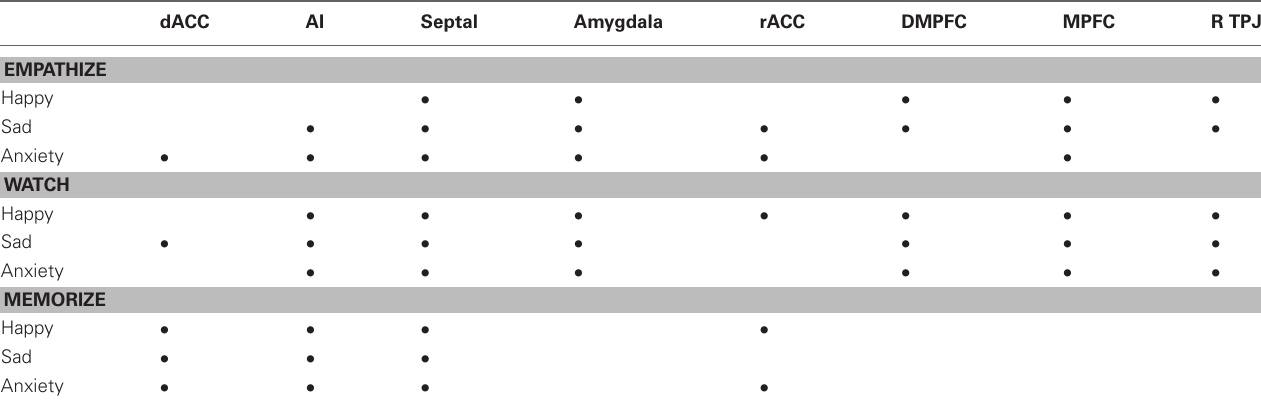
Table 1 | Patterns of neural activity for each instruction type (compared to viewing neutral photos) within anatomically-defined regions of interest previously associated with empathy, emotion, and